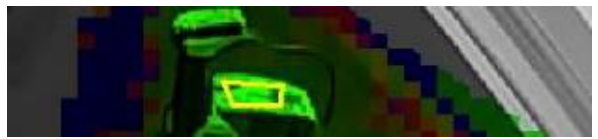
Figure 7: Reference areas on the Scanner body for deformation analysis: Yellow outlined area on the scanner’s body.